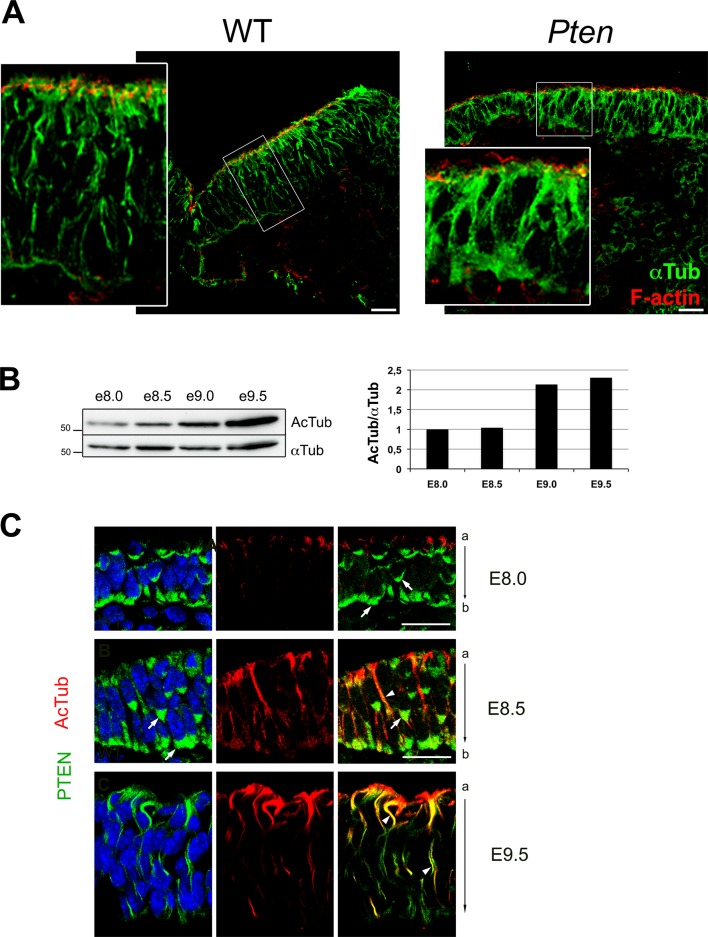
Acetylated microtubules in the wild type cranial neural plate.(A) α-Tubulin appears to be in apical-basal arrays in E8.5 wild-type cranial neuroepithelial cells but is more diffuse in Pten △Epi embryos. Red is phalloidin. Scale bar = 20 µm. (B) Western blot analysis shows that of acetylated tubulin increases during maturation of the wild-type neural plate. Each lane represents a pool of the cephalic regions of three embryos. (C) Acetylated microtubule arrays increase with time in the cranial neural plate of WT embryos and acetylated tubulin partially colocalizes with PTEN protein beginning at E8.5. Green is PTEN, acetylated tubulin is red; blue is DAPI. Arrows highlight sites of PTEN enrichment and arrowheads show examples of sites of colocalization of PTEN and acetylated tubulin. Scale bar = 25 μm.